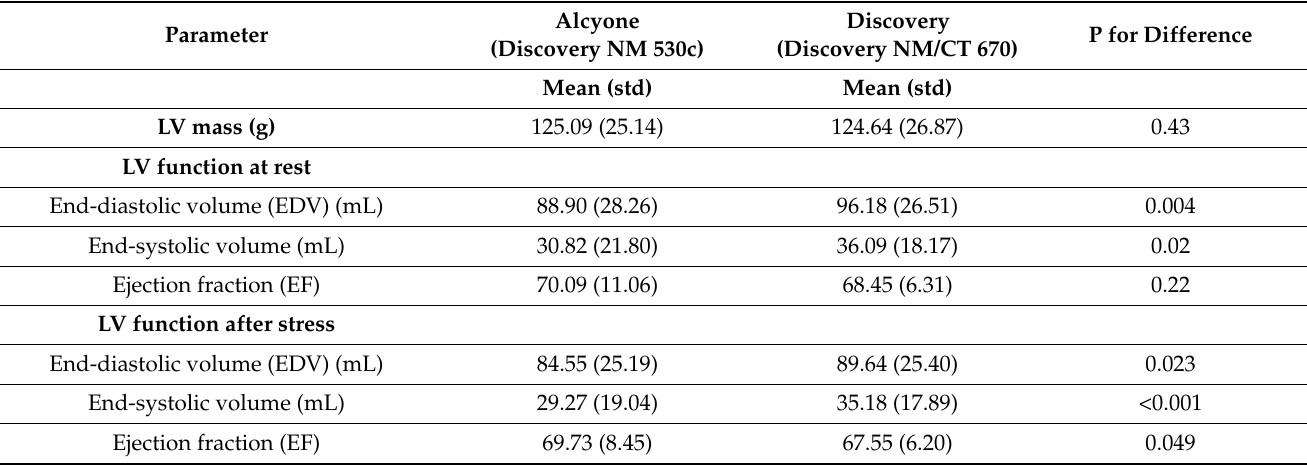
Table 9. Clinical parameters